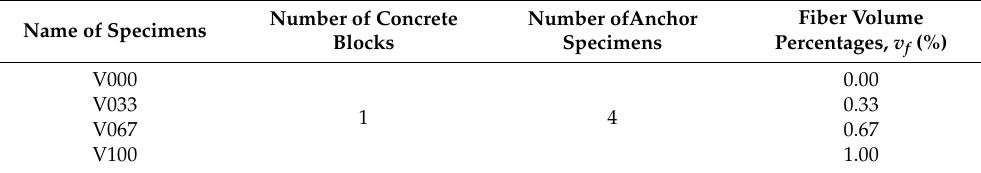
Table 2. Specimen names and numbers according to fiber volume fractions.